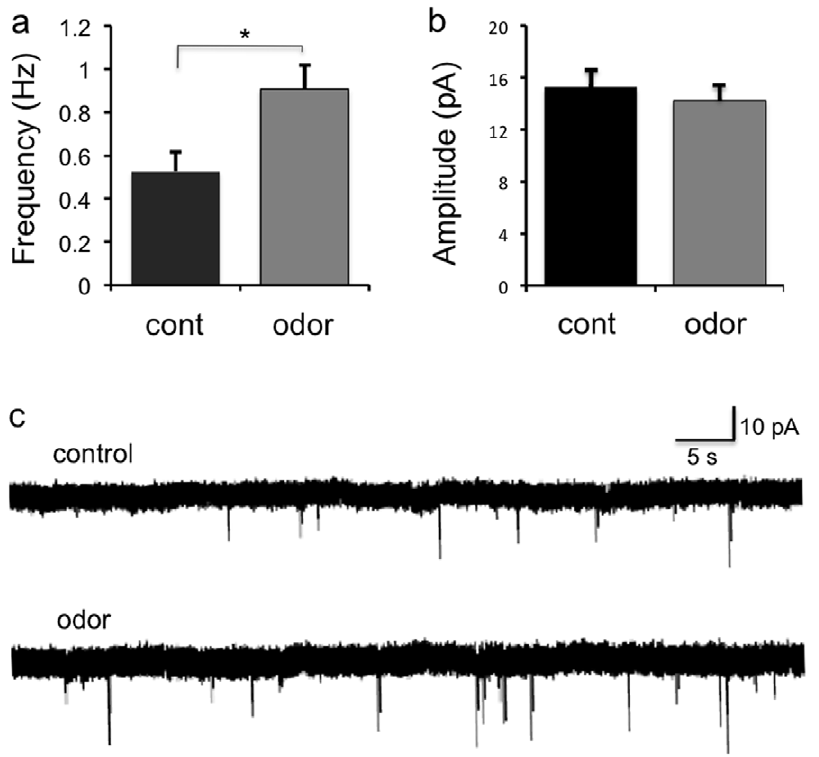
Figure 6. Odor Enrichment Increases Inhibitory Drive Onto Newborn Granule Cells. (a)–(b) Quantitative analysis of (a) average frequency and (b) amplitude of mIPSCs recorded from labeled granule cells in control and odor-enriched mice. Odor enrichment increased the frequency, but not amplitude, of granule cell mIPSCs (control, n=9; odor, n=10, * p , 0.01, unpaired t-test). (c) Representative voltage-clamp recordings of mIPSCs from granule cells in acute MOB slices from control and odor-enriched